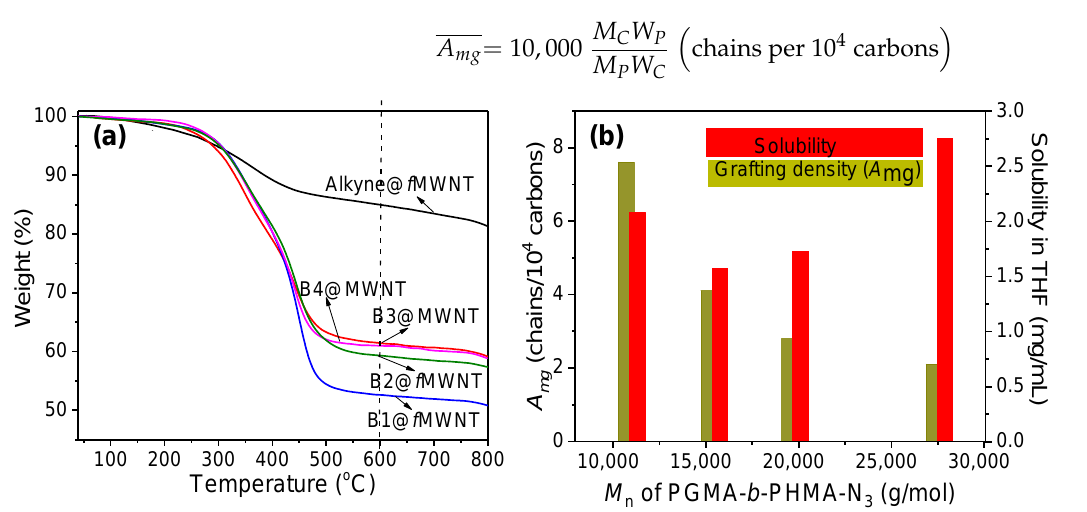
Figure 2. TGA curves ( a ) and solubility and grafting density ( b ) of bc@ f MWNTs brushes with dif- ferent PGMA- b -PHMA-N 3 average molecular weights.